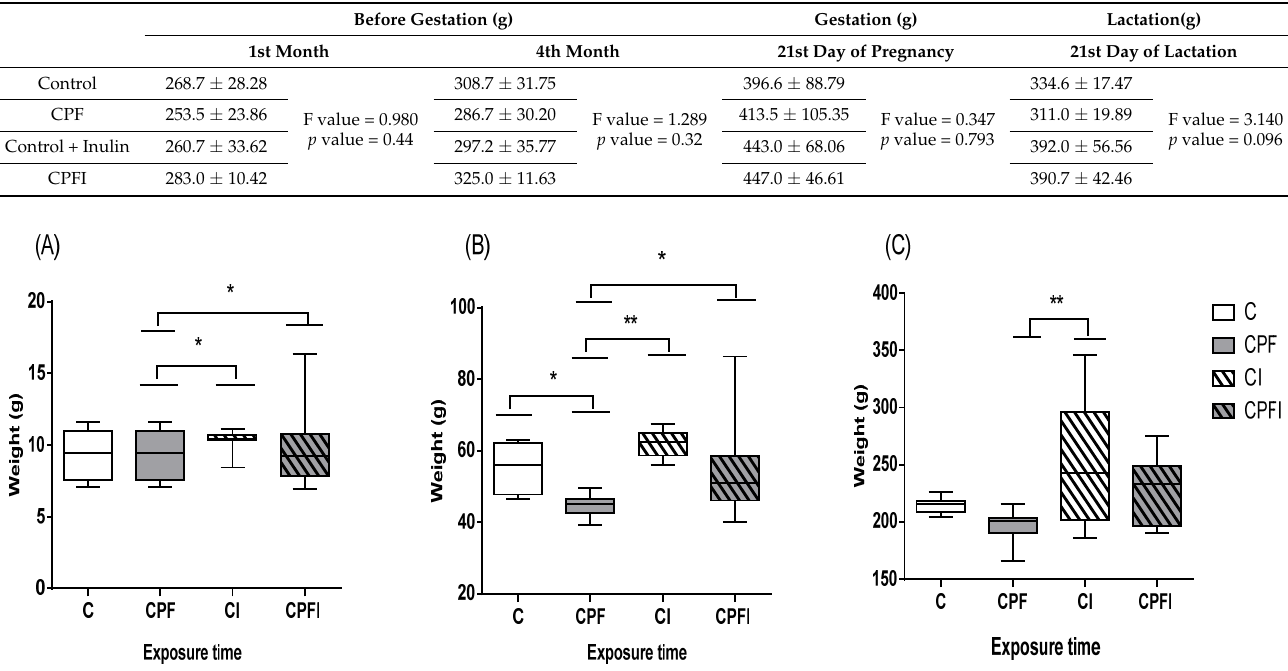
Figure 2. Effects of perigestational exposure to CPF and inulin on the body weight of the offspring of female rats 3 days after birth (PND3, ( A )), as juveniles (PND21, ( B )) and young adults (PND60, ( C )). Values are expressed as mean ± SEM ( n = 7–10) using analysis of variance (ANOVA) and Tukey’s test. Significance * p < 0.05; ** p < 0.01; C: Control; CPF: Chlorpyrifos; CI: Control inulin; CPFI: Chlorpyrifos + inulin; PND: post-natal day.